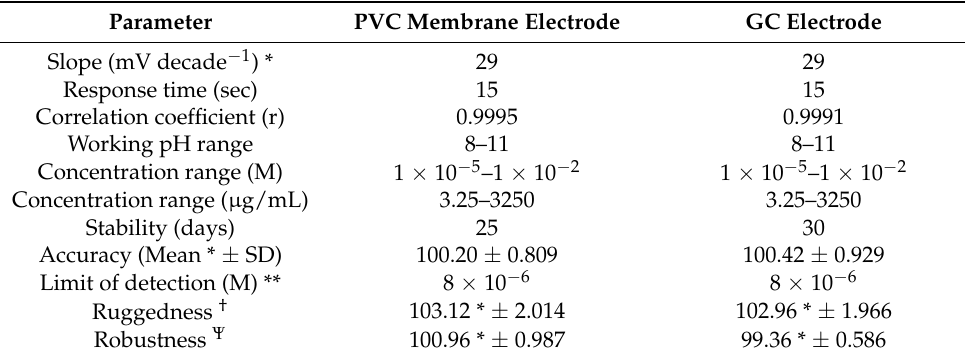
Table 2. Electrochemical response characteristics of the fabricated electrodes.